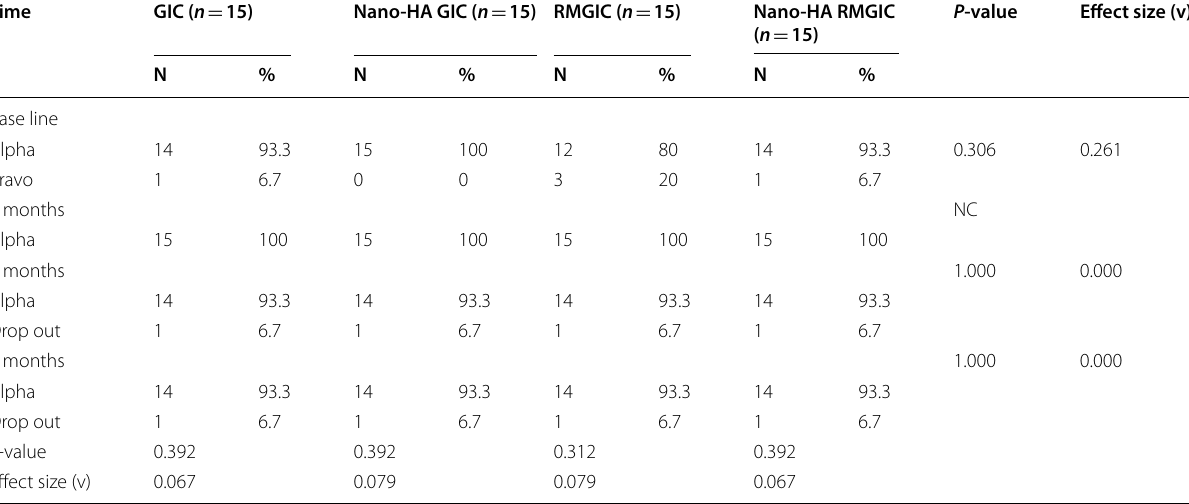
*Significant at P